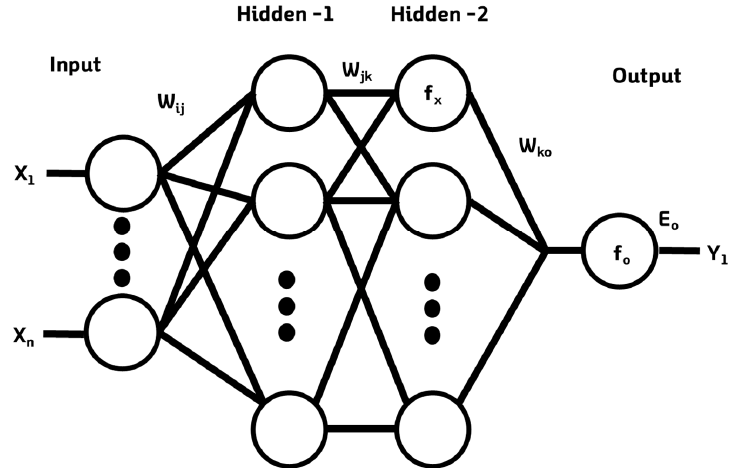
Figure 4. Example of a feed-forward back-propagation ANN model.